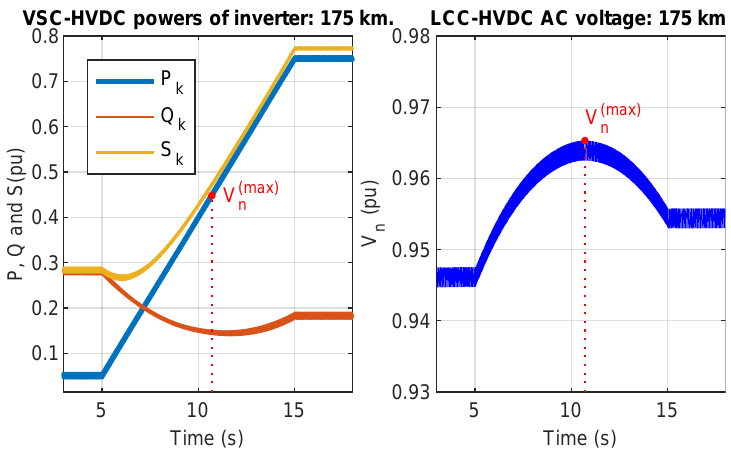
Figure 6. VSC power variations and LCC inverter AC bus